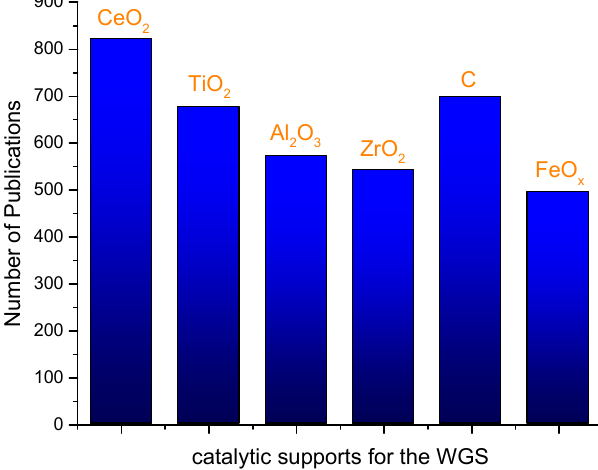
Figure 7. Number of published papers available in Scopus Scholar data base using “gold catalysts” and “WGS” and “CeO 2 ” or “TiO 2 ” or “ZrO 2 ” “Carbon supports” or “Al 2 O 3 ” or “Fe 2 O 3 ” as search strings (September 2016).